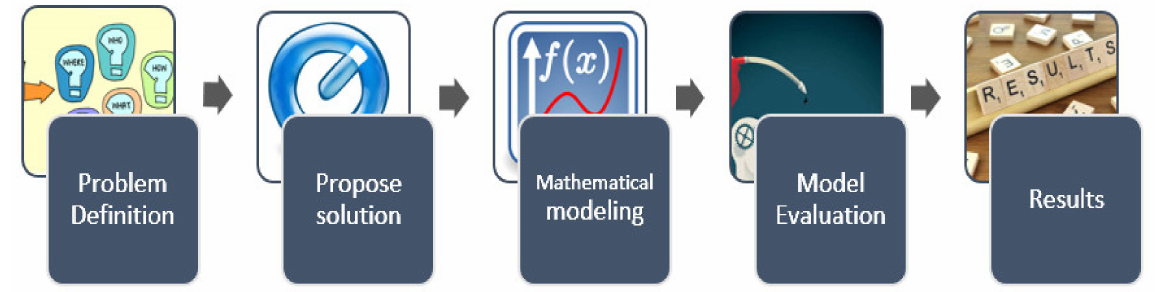
Figure 6. Steps of Mathematical modeling to validate the proposed